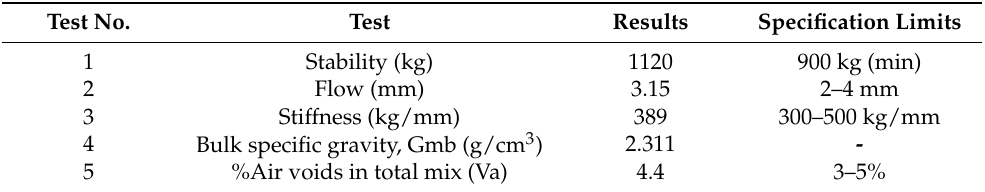
Table 4. Marshall properties at optimum bitumen content (OBC).